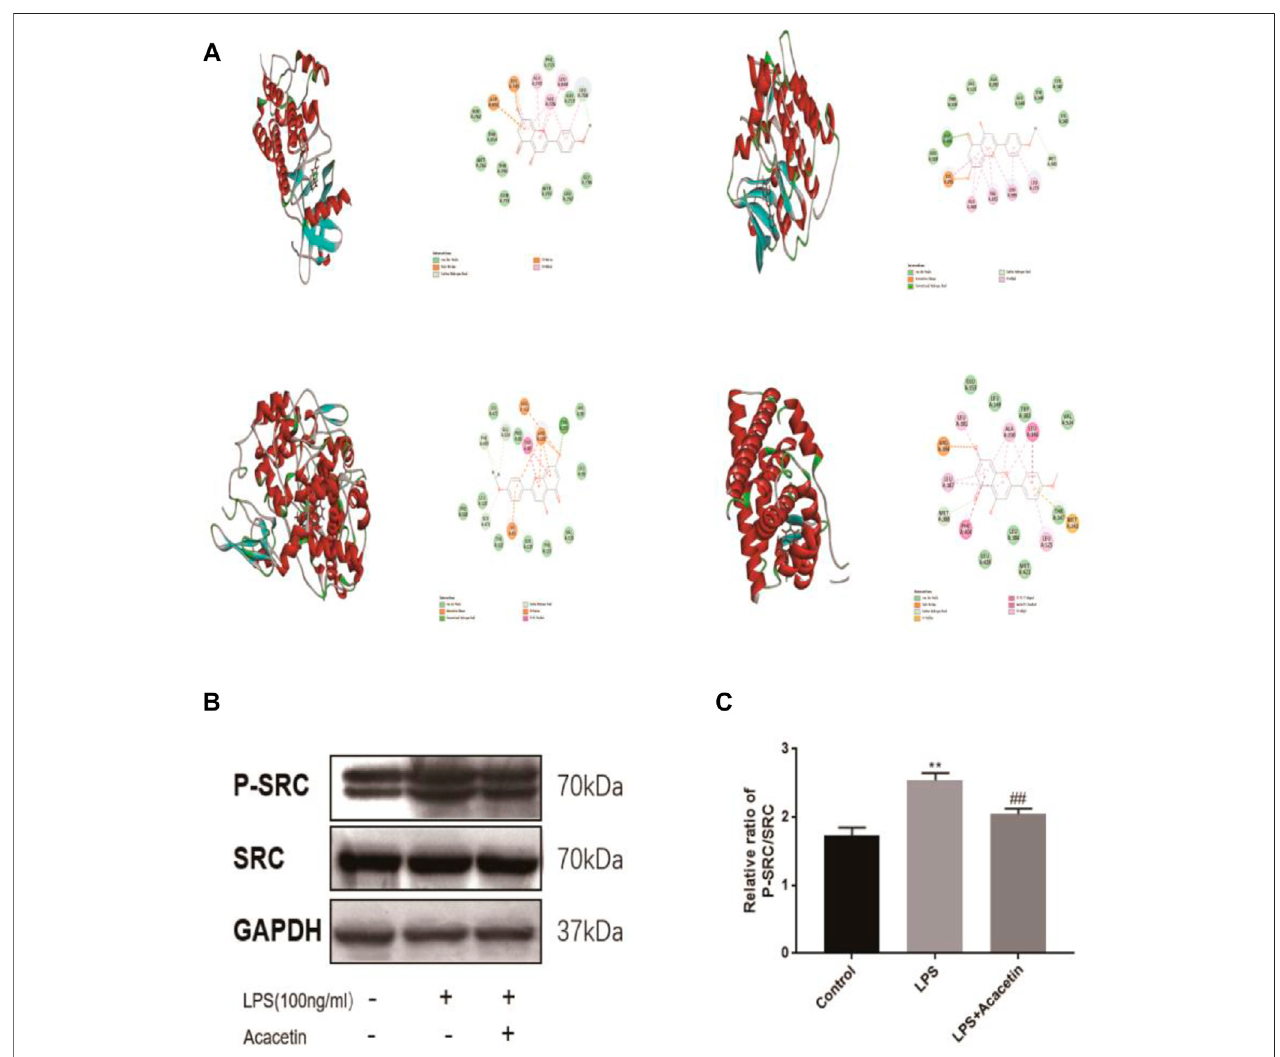
FIGURE 4 | Molecular docking and experimental validation of acacetin binding core targets predicted by network pharmacology. (A) EGFR, SRC, PTGS2 and ESR1.Allpicturesshowthe3Ddockingofligandsintheactivebindingpocket,withthehydrophobiceffectareaandthe2Dinteractionpatternsbetweentheligandsand proteins and the important interactions between the ligand atoms and amino acid residues of the proteins being displayed. (B – C) The expression levels of Src and phosphorylatedSrcwereassessedviaWesternblotting.Thedataareexpressedasthemean ± SEM( n (cid:1) 3).* p < 0.05,** p < 0.01,and*** p < 0.001comparedwith the control group; # p < 0.05, ## p < 0.01, ### p < 0.001 compared with the LPS-stimulated